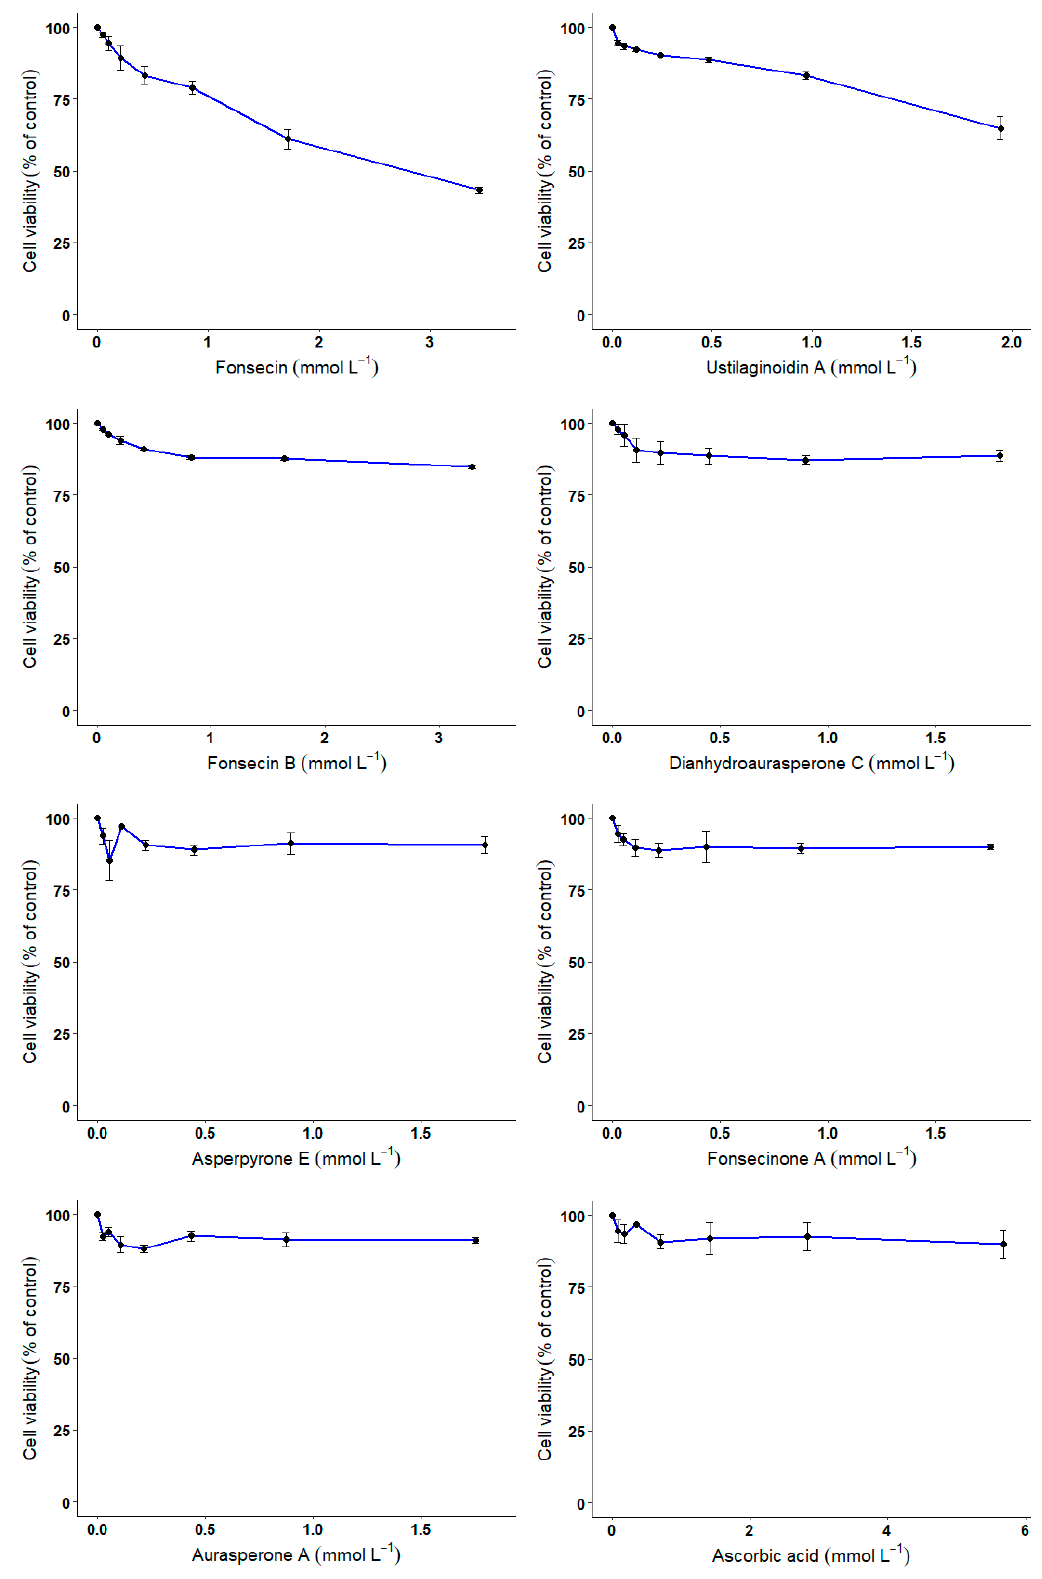
Figure 5. Innocuity testing of compounds 1 – 7 on Chinese hamster ovary (CHO) cells. CHO cells were exposed for 24 h to increasing concentrations of compounds 1 – 7 or ascorbic acid. At the end of the incubation period, cell viability was evaluated using Alamar blue assay. Error bars represent the variability associated with the measurements of triplicate samples.